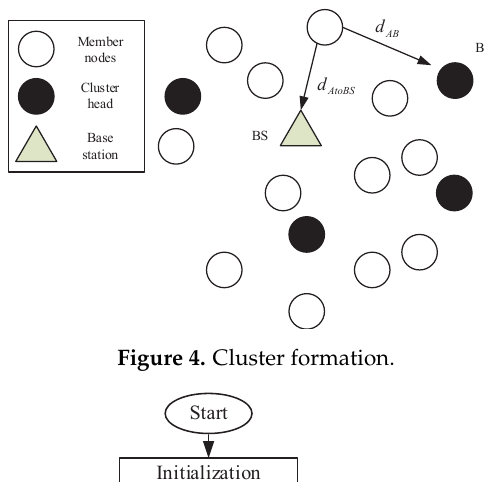
Figure 4. Cluster formation.